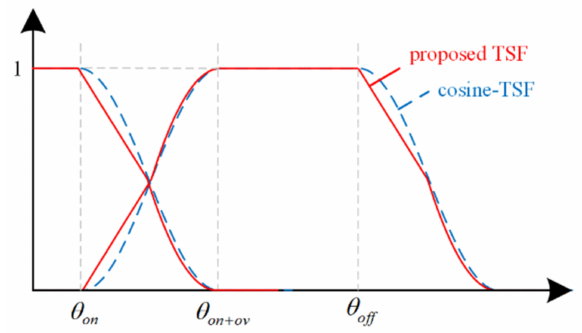
Figure 3. The cosine and proposed TSF.